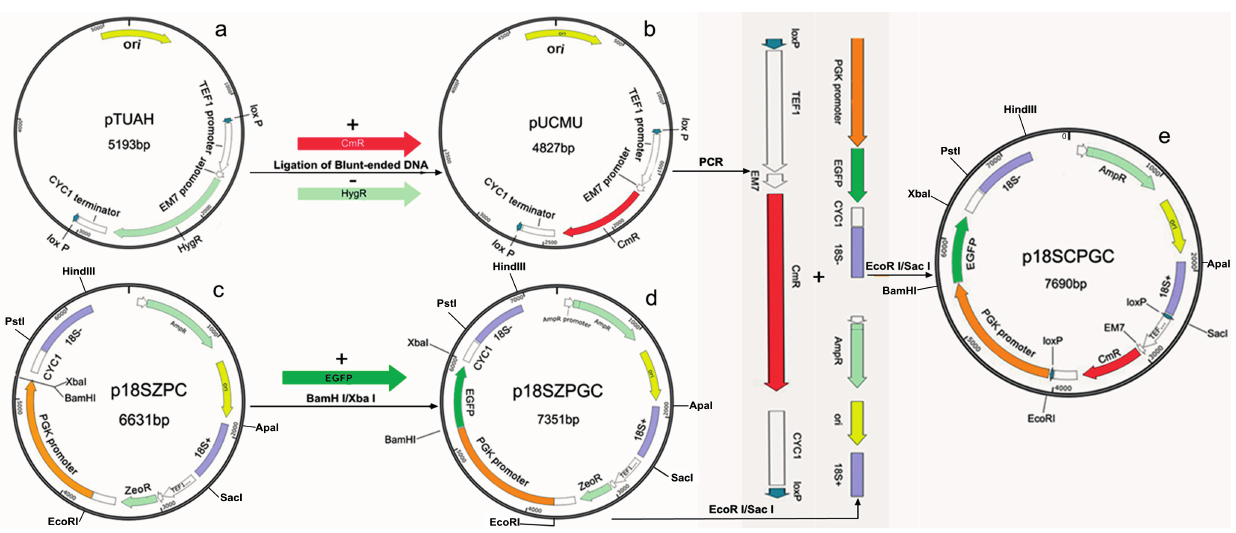
Figure 1. Construction process of the plasmid. ( a ) Plasmid pYUAH; ( b ) Plasmid pUCMU; ( c ) Plasmid p18SZPC; ( d ) Plasmid p18SZPGC; ( e ) Plasmid